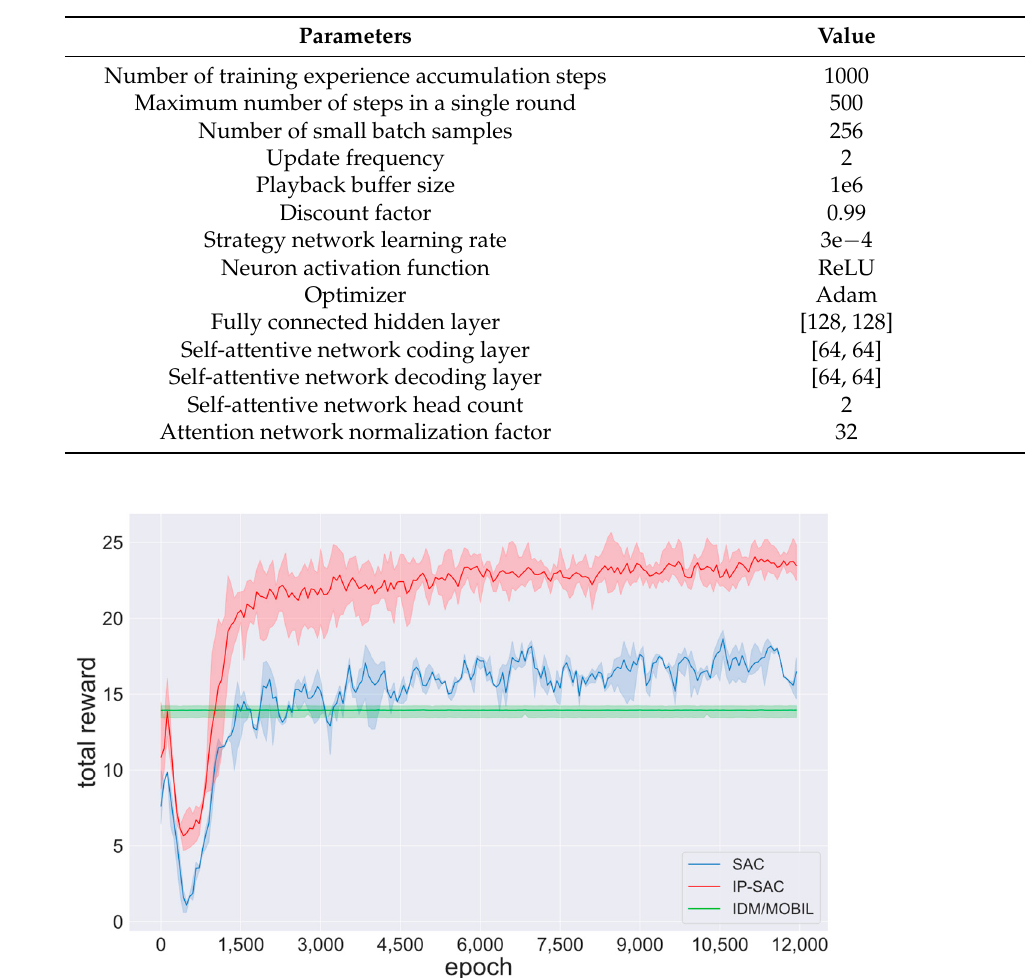
Figure 9. The average speed of SAC and IP-SAC policies.